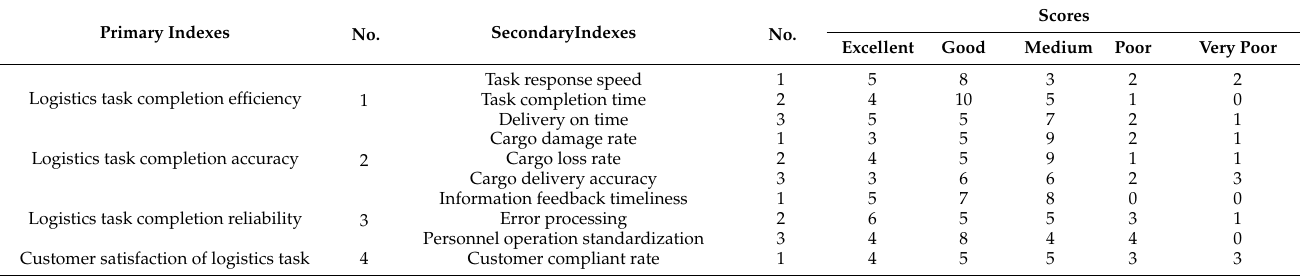
Table 6. Score data of logistics task completion quality.